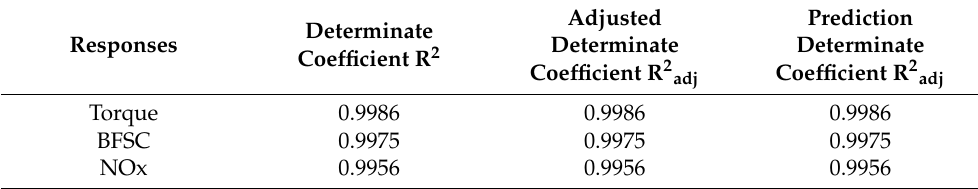
Table 5. Each response surface model